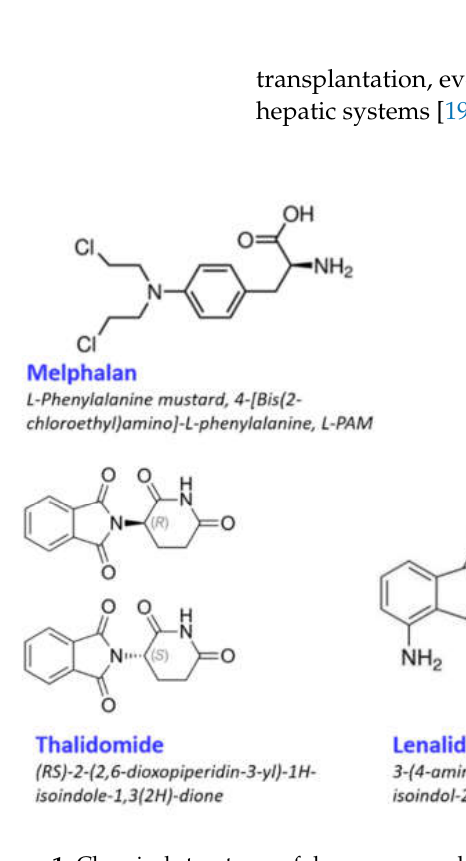
Figure 1. Chemical structures of drugs commonly used in the induction phase for the treatment of patients with multiple myeloma. Thalidomide is included only for comparison to its derivative lenalidomide.